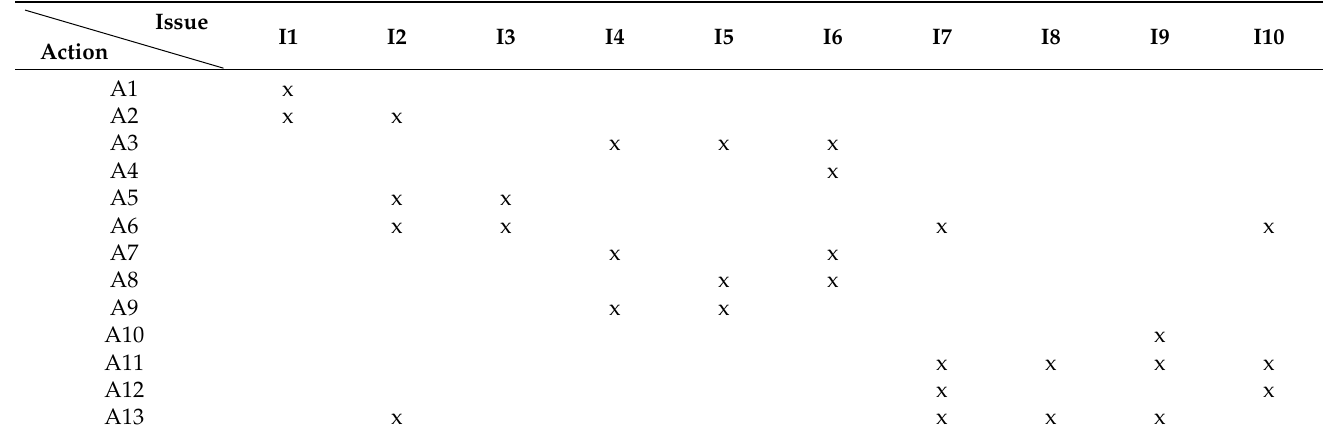
Table 4. Issues addressed by